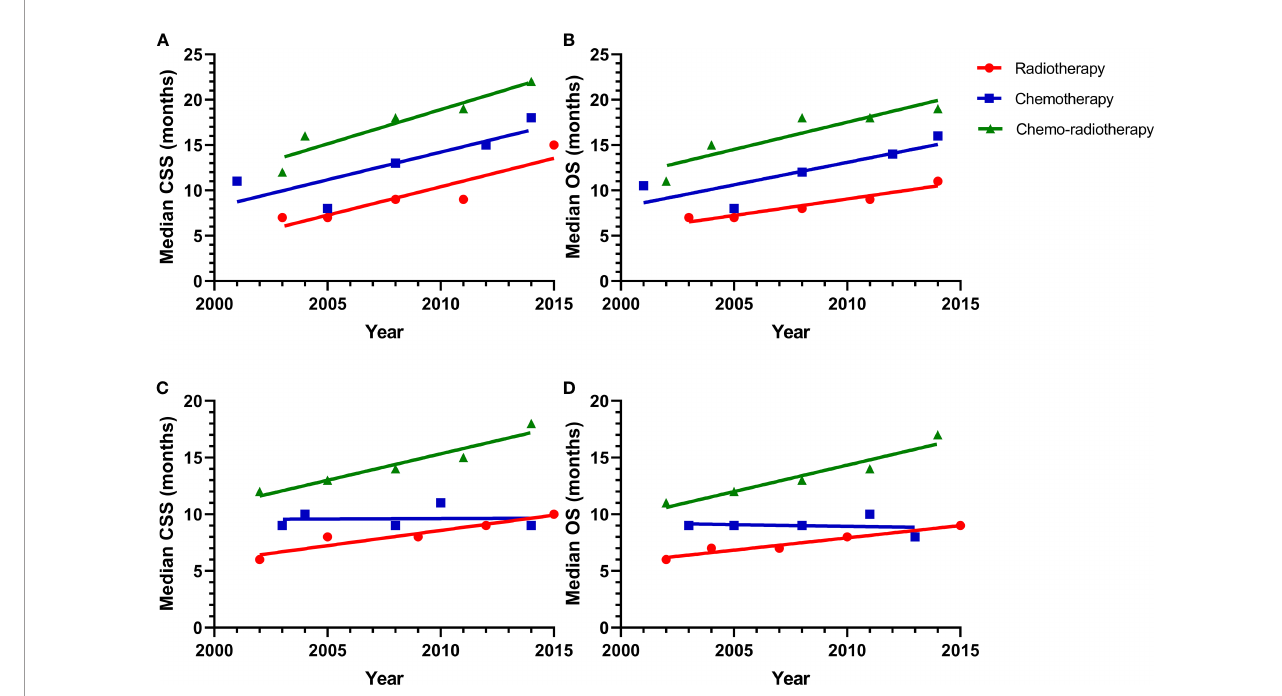
FIGURE 3 | (A) A linear regression model for median survival of CSS of patients with adenocarcinoma in the radiotherapy alone (r = 0.8304, P = 0.0313), chemotherapy alone (r = 0.7036, P = 0.0758), and chemo-radiotherapy groups (r = 0.8900, P = 0.0160); (B) A linear regression model for median survival of OS of patients with adenocarcinoma in the radiotherapy alone (r = 0.9268, P = 0.0086), chemotherapy alone (r = 0.7069, P = 0.0744), and chemo-radiotherapy groups (r = 0.8176, P = 0.0351); (C) A linear regression model for median survival of CSS of patients with non-adenocarcinoma in the radiotherapy alone (r = 0.8995, P = 0.0140), chemotherapy alone (r = 0.001392, P = 0.9525), and chemo-radiotherapy groups (r = 0.9245, P = 0090); (D) A linear regression model for median survival of OS of patients with non-adenocarcinoma in the radiotherapy alone (r = 0.9503, P = 0.0048), chemotherapy alone (r = 0.02941, P = 0.7827), and chemo-radiotherapy groups (r = 0.9245, P =